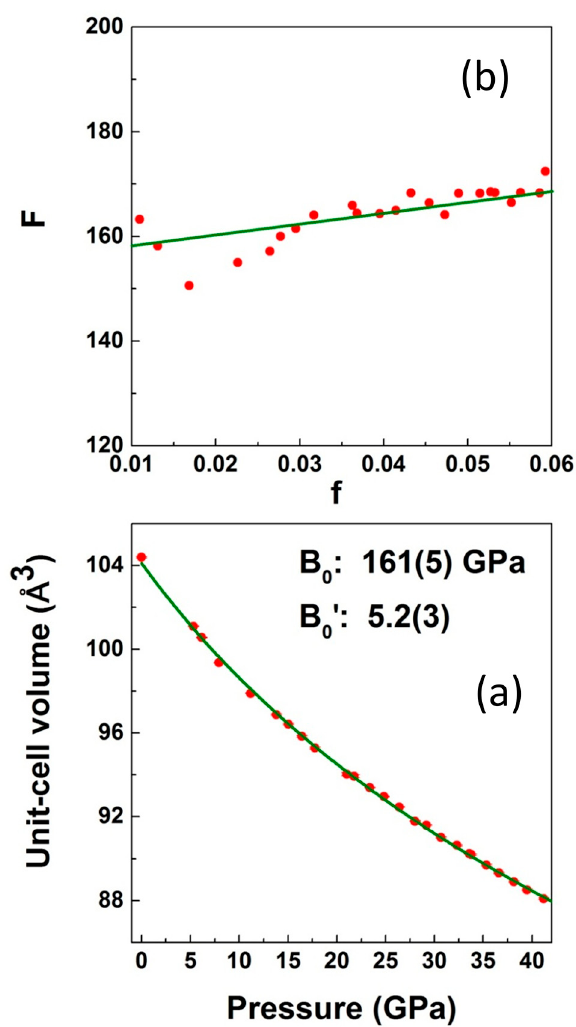
Figure 10. ( a ) Isothermal equations of state data for LiCrO 2 . Solid squares are experimental data points and solid line is the third order Birch–Murnaghan equation of state fit to the data points. Errors in the volume are smaller than the symbol used. ( b ) Top panel shows the same data converted to F-f plot (see the text).